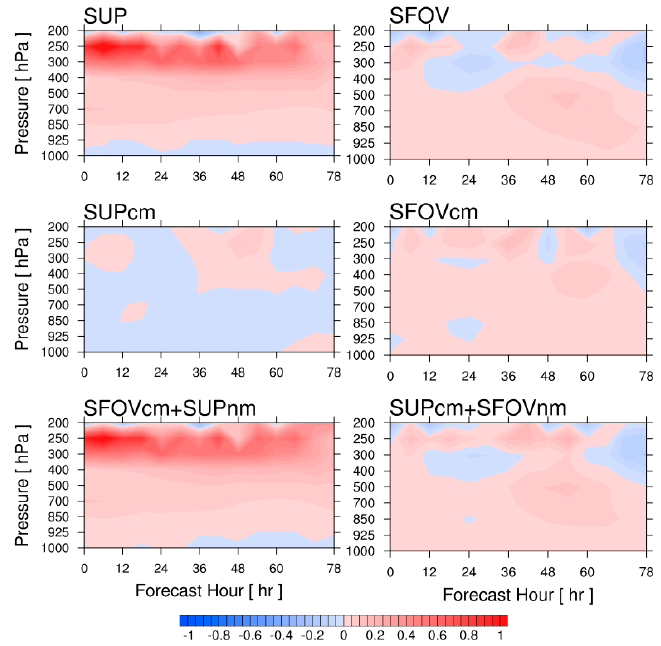
Figure 9. The forecast impact ( FI ) of the individual experiments in Tables 1 and 2. Warm (cold) colors suggest a positive (negative) contribution to the forecast system when compared to the control run.